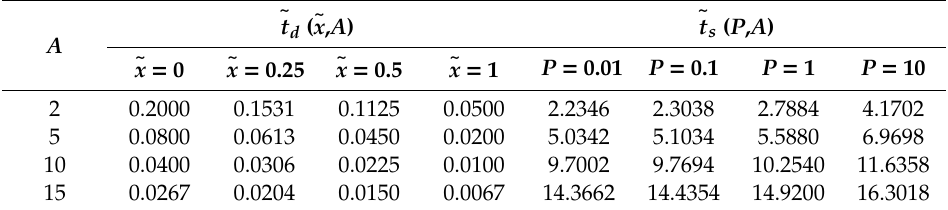
Table 1. Deviation time and quasi-steady times for di ff erent numerical accuracies A